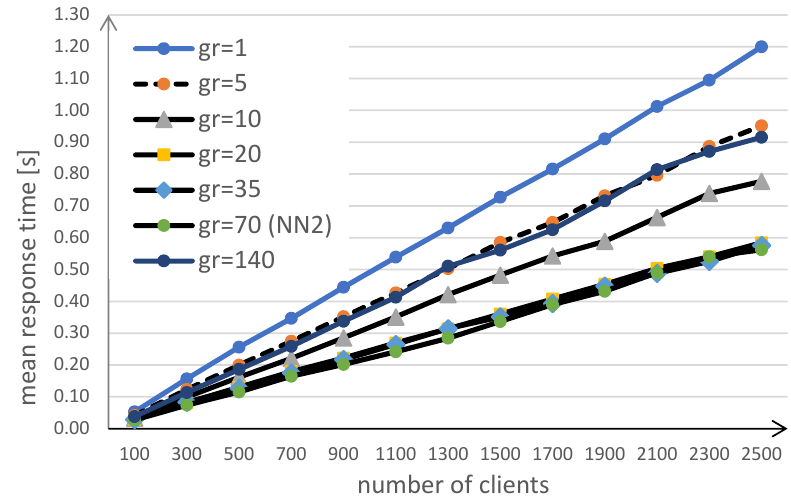
Figure 8. Division into groups with a balanced number of requests.